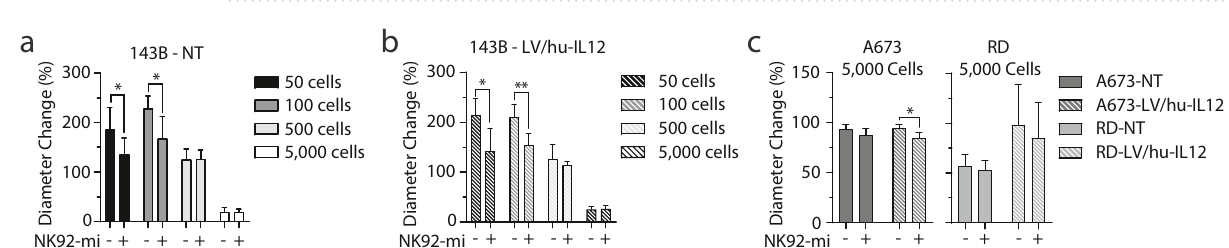
Figure 4. Osteosarcoma (143B) ( a ) Non-transduced (NT) and ( b ) LV/hu-IL-12 transduced sarcoma lines were plated in ultralow adherent 96-well plates at escalating doses from 50 to 5000 while ( c ) Ewing sarcoma (A673), and rhabdomyosarcoma (RD) plated at 5000 cells/well. After 48 h, spheroid formation was verified, diameters were recorded, and 1,000 NK-92mi cells were added. Diameters were recorded every 24 h and displayed as Δ96 h. N = 4, displayed mean ± standard deviation. * = p < 0.05, ** = p < 0.001, *** = p <